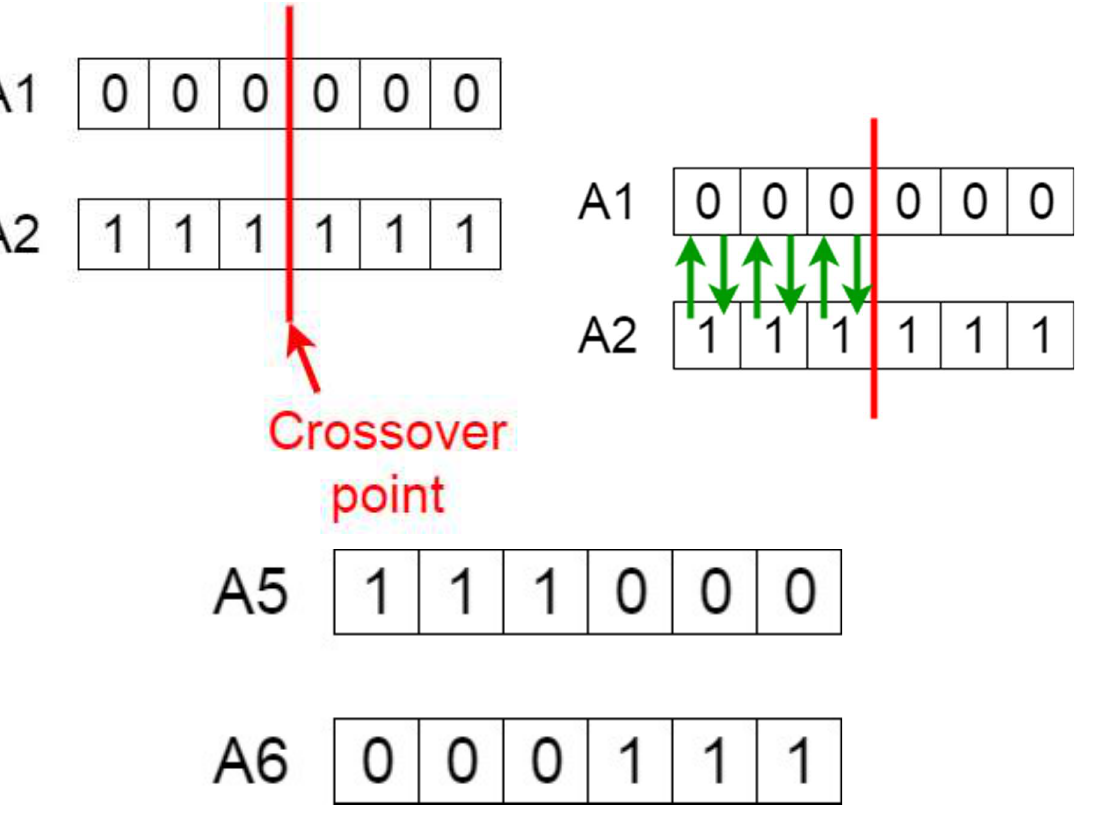
Figure 12. Top left: crossover point, top right: exchanging genes among parents, bottom: new offspring.